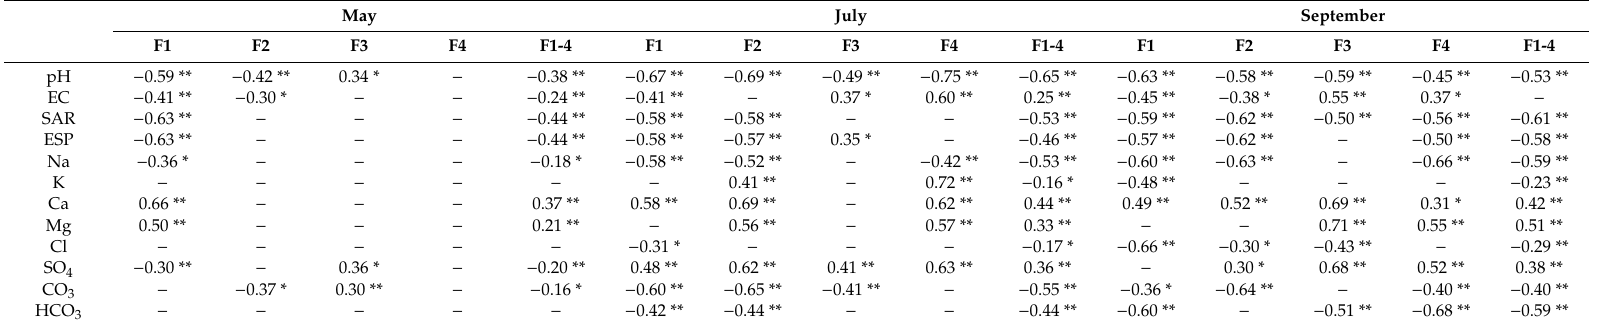
Table 8. Correlation coe ffi cients (r) of soil properties and maize production from May to September in each experimental